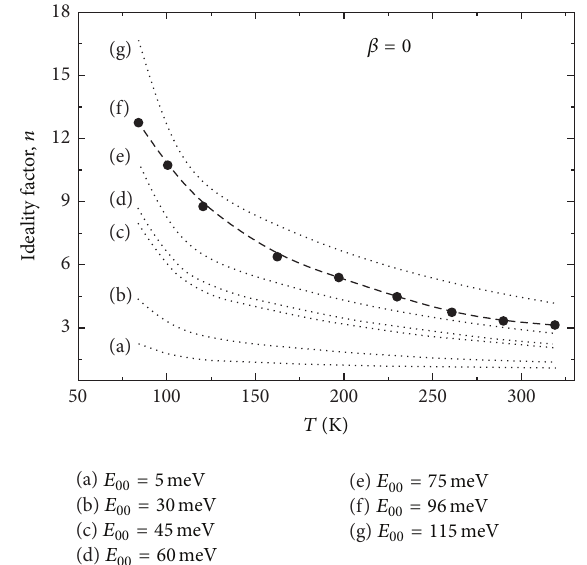
Figure 5: Thermionic field emission (TFE) fits obtained by fitting (6) to the temperature dependence values of experimental ideality factorscalculatedfordifferentvaluesofthecharacteristicenergy 𝐸 00 , without considering the bias coefficient of the barrier height, 𝛽 = 0 , for Al/poly(4-vinyl phenol)/ p -GaAs structure. The filled circles show the temperature dependence values of experimental ideality factor obtained from the I-V